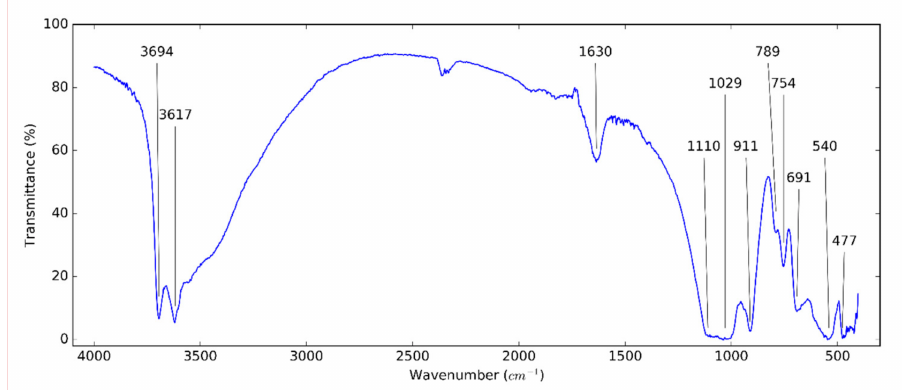
Figure 3. Fourier transform infrared (FT-IR) spectrum of HNTs.